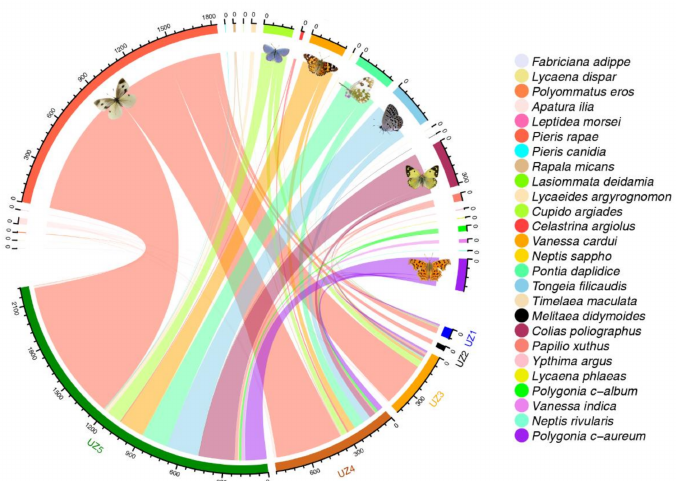
Figure 2. Distribution of 3617 individuals within 26 butterfly species in five urban zones (UZ1–5) in Beijing, China. The presence of a link means that the species is distributed in this urban zone. The width of the links between butterfly species and each urban zone show the distribution extent of the butterfly in this urban zone. Scale numbers around the top half of the circle indicate the number of each butterfly species. Scale numbers around the lower half of the circle indicate the number of butterfly individuals distributed in each urban zone. Each relatively abundant butterfly species is graphically marked with realistic images.